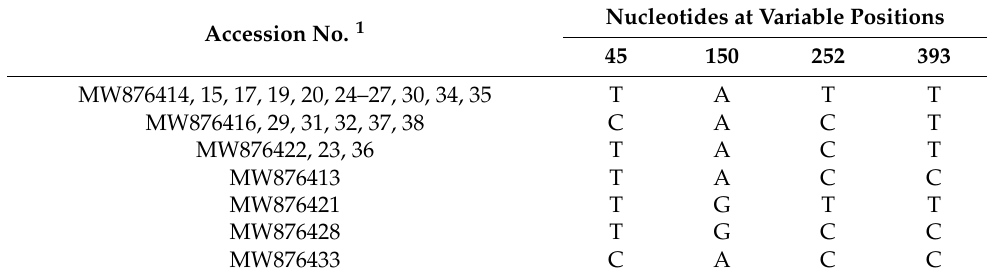
Table 3. Nucleotide variations among the 30 GDH sequences detected from the feces of 792 calves. Nucleotides at Variable Positions Accession No. 1 258 306 342